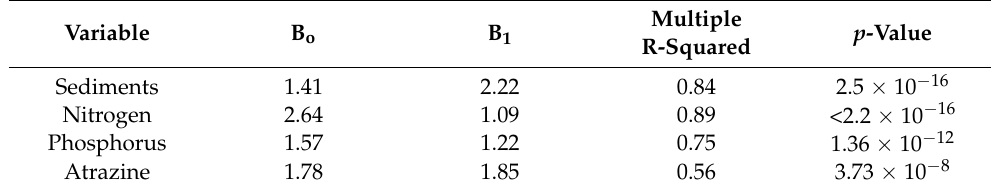
Multiple p -Value R-Squared